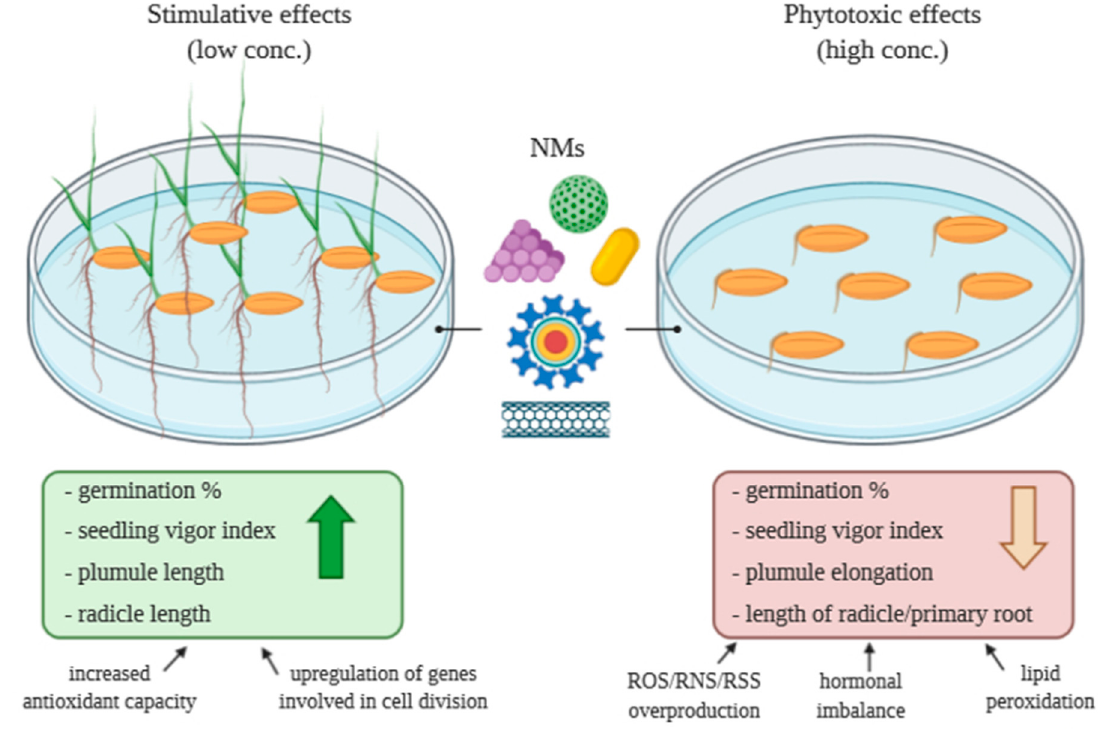
Figure 4. Schematic model summarizing the stimulative or inhibitory pathways of NMs on seed germination (figure created in BioRender.com).